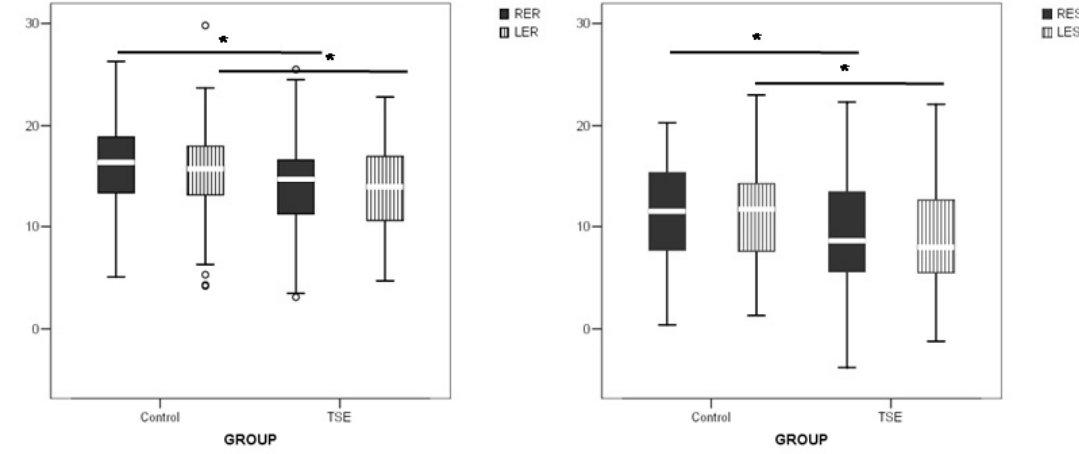
Figure 1. TEOAE response level and signal/noise response level of right (RE) and left (LE) ears of tobacco smoke exposure (TSE) students and their controls. Upper bars indicate comparison between groups per ear. * p <